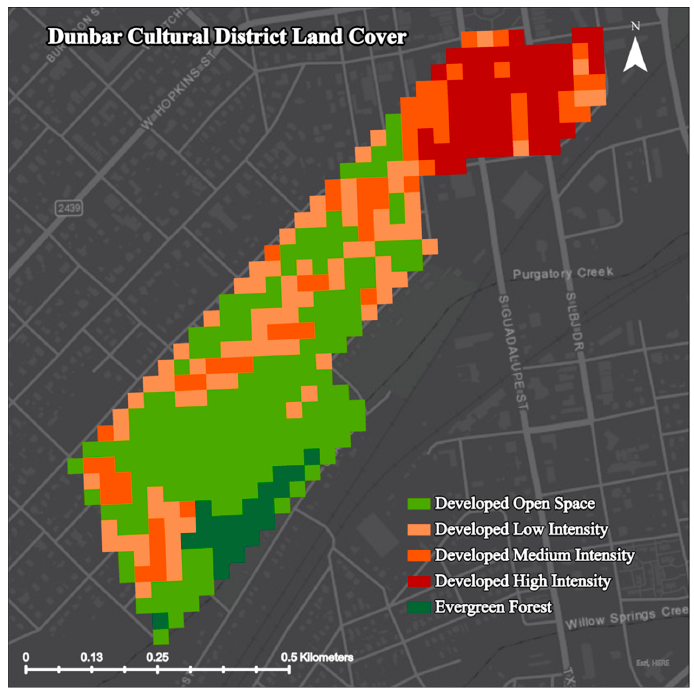
Figure A2. Dunbar Cultural District Land Cover. Dunbar Cultural District landcover/land use map. National Land Cover Database (2016) was used to visualize the land cover/land use. Data for this map were obtained from Texas Natural Resource Information System and Esri basemaps.